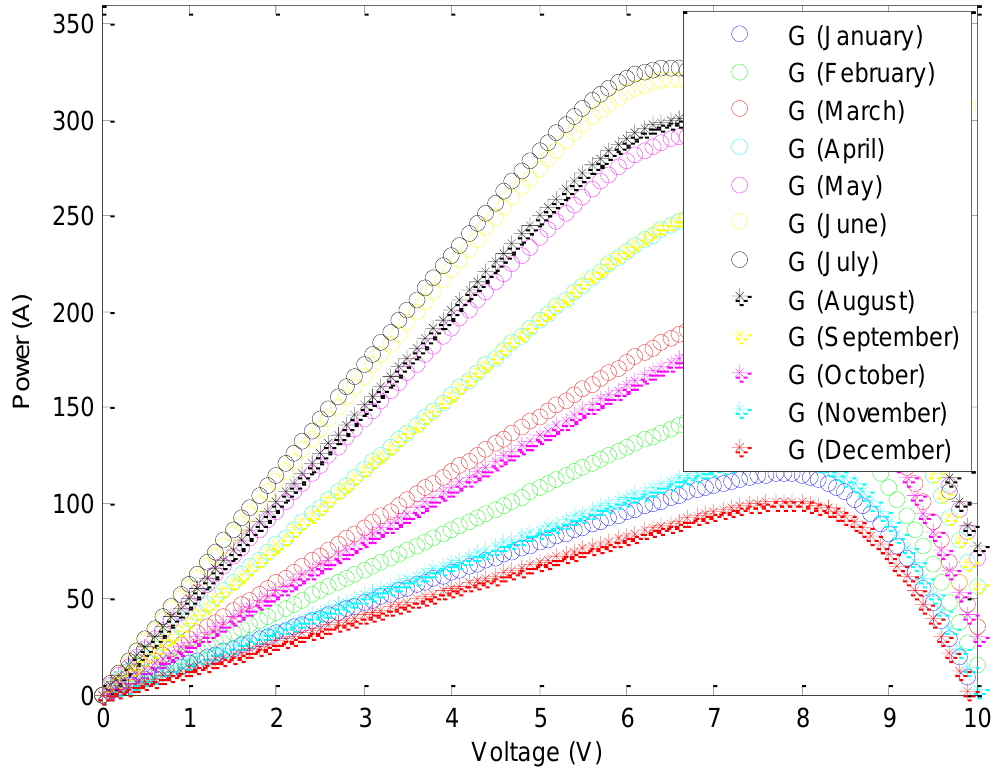
Figure 9. Power-voltage characteristic curves of photovoltaic cells for various irradiation and constant temperature in Vlore, Albania.